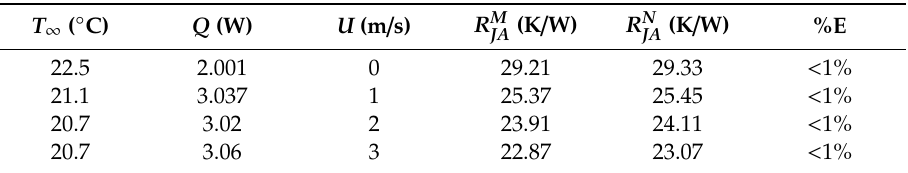
Table 4. Fitting of the 2s2p thermal metrics (Icepak ® ).